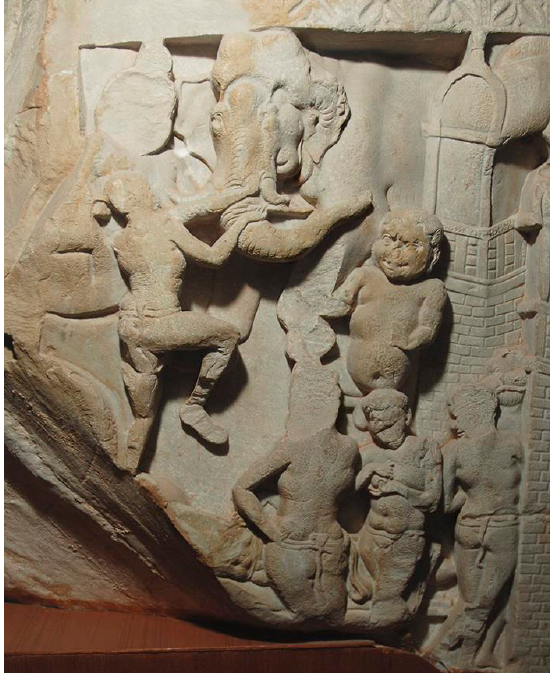
Figure 5. Part of relief no. 75 in Chennai Government Museum © photograph Wojtek Oczkowski.